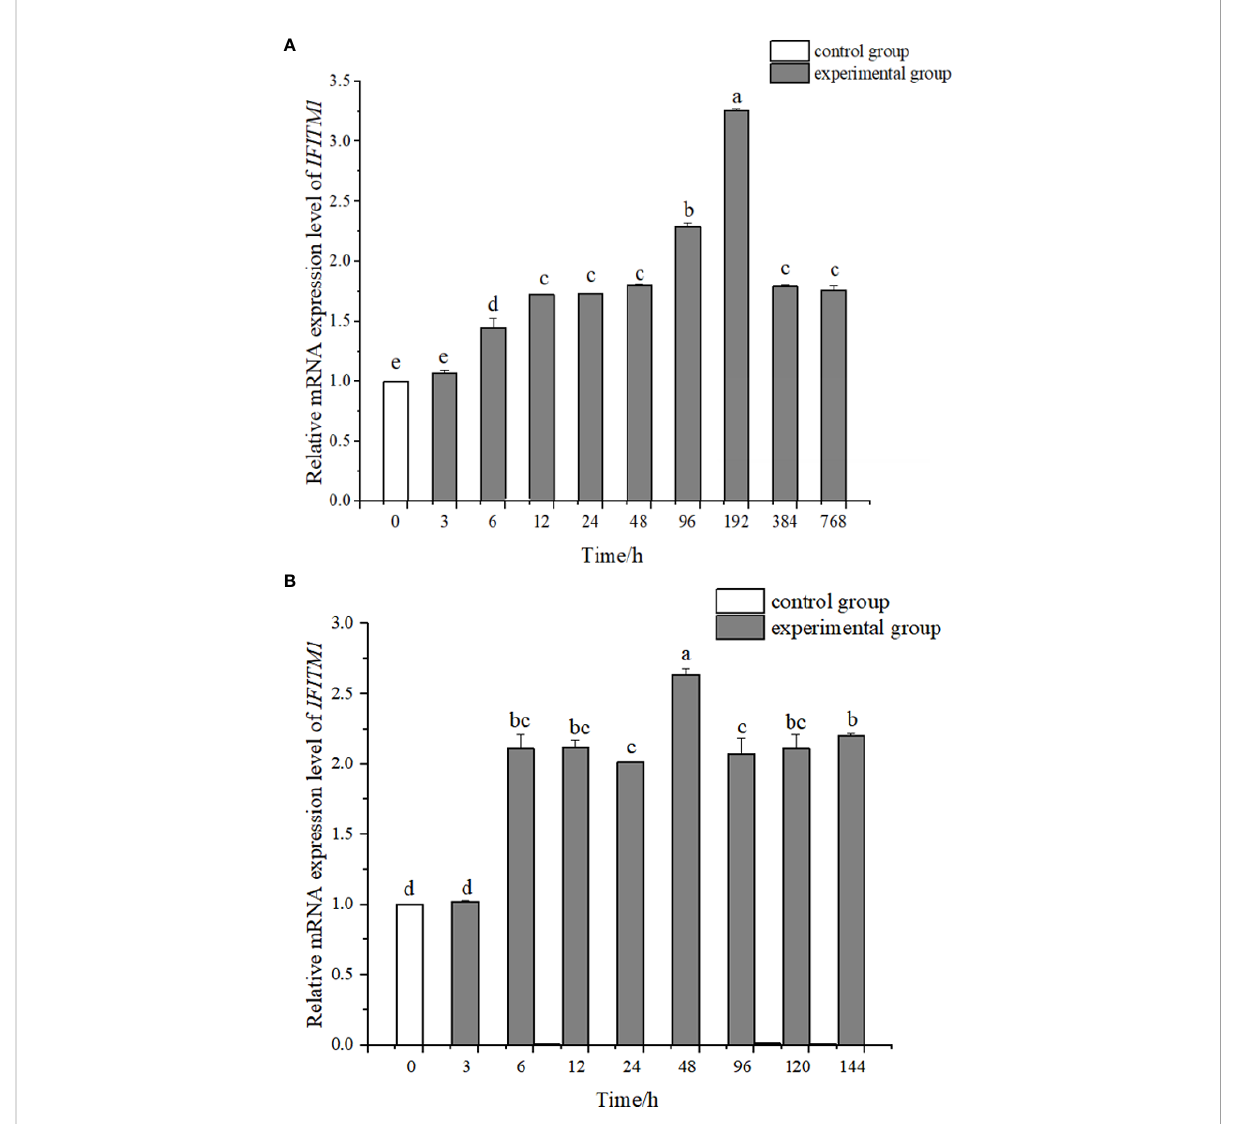
FIGURE 7 Expression of the IFITM1 gene in the hepatopancreas tissue of Cyclina sinensis . (A) Gene expression in C sinensis exposed to long-term ammonia. (B) Gene expression in C sinensis infected with Vibrio parahaemolyticus . Different letters in the column indicate signi fi cant difference ( p <